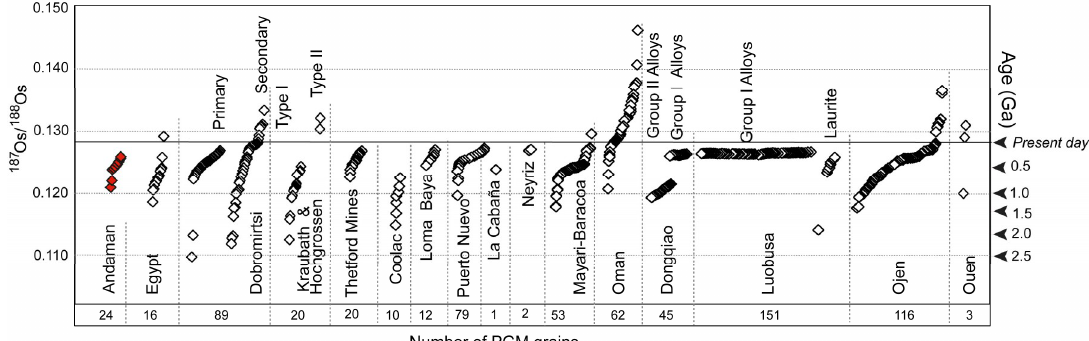
Figure 11. 187 Os / 188 Os isotopic ratios and corresponding T RD model ages for PGM analyzed in this study (red diamonds) and other analyzed in situ in chromitites from ophiolite worldwide; updated after [71].